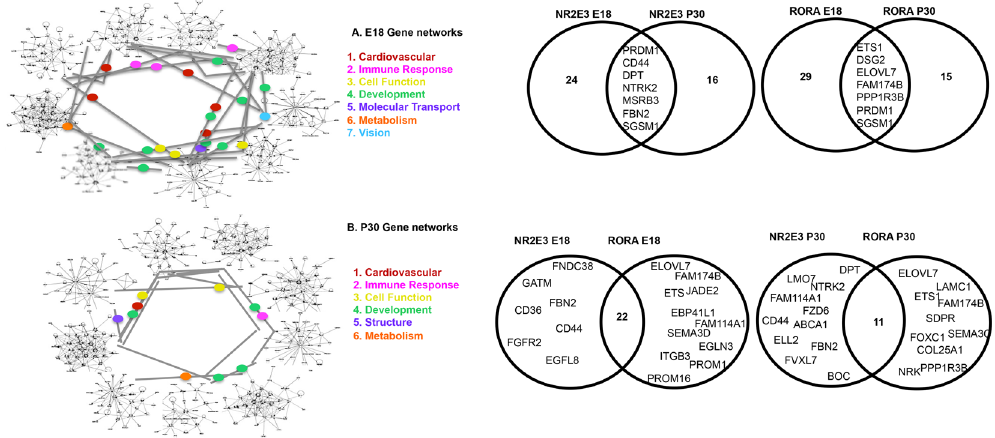
Figure 3. Interacting NR2E3 and RORA Associated Gene Networks. ( A ) IPA analysis of E18 targets identified 9 gene networks with 7 biological classifications. ( B ) IPA analysis of P30 targets identified 9 gene networks with 6 biological classifications. Venn Diagrams show unique and overlapping gene targets of NR2E3 and RORA at E18 and P30. Comparisons of RORA E18/P30 or NR2E3 E18/P30 show less overlap than RORA/NR2E3 at E18 or RORA/NR2E3 at P30.